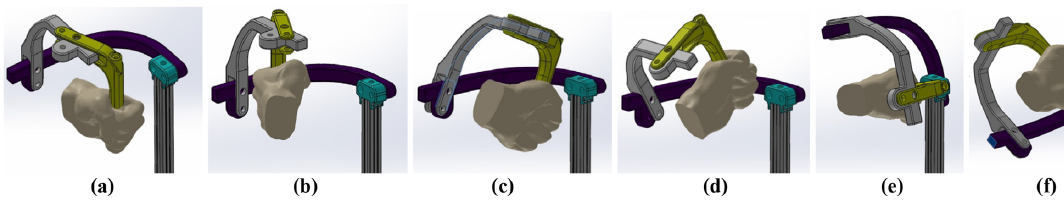
Figure 4. Solid models of the exoskeleton with virtual hand.